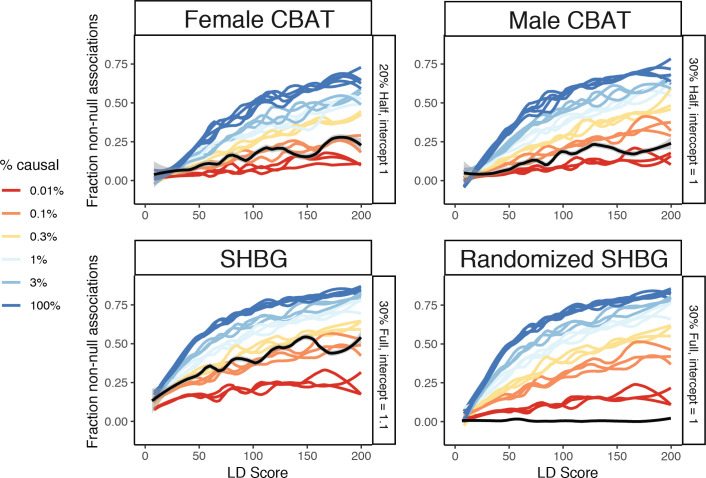
Prediction plots for the causal SNP counts underlying calculated bioavailable testosterone (CBAT) in females and males, as well as sex hormone binding globulin (SHBG) and a randomized version of SHBG.CBAT traits are similar to their testosterone counterparts and SHBG is estimated to have slightly more causal variants (≈0.2%).